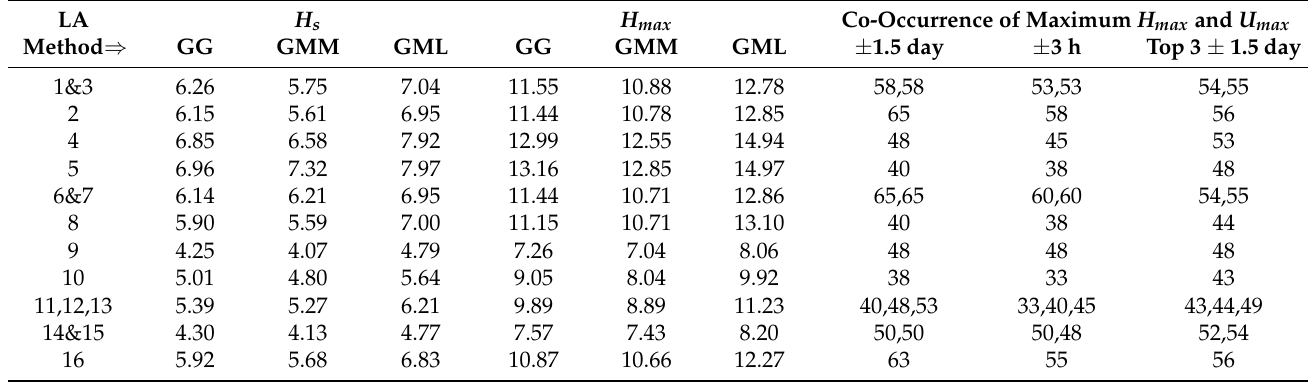
Figure 9. Time series of annual maximum wave heights H max from ERA5 for the LA shown in Figure 1. The top panel shows results for the northern group of LA (1–7) off the coast of MA/RI, the center panel shows the mid LA 8–13 off the coasts of NY, NJ, DE and MD and the lower panel the south LA 14–16 off the coast of VA and NC. The color coding for the individual LA is shown in Figure 1b. Because the ERA5 grid for wave data is at a lower resolution, some of the LA are in the same ERA5 grid (1&3, 6&7, 11,12 & 13, 14&15) hence these data points overlie each other. Table 4. One-year return periods for H max and H s (m) for the different LA determined by three different methods. LA that are within a common ERA5 grid cell for wave output are clustered in the same row. Also shown is the co-occurrence of annual maximum H max and U max sampled in three different ways; in the first analysis co-occurrence was specified as the percentage of the 40 years wherein the maximum absolute wave height occurred within 1.5 days of the maximum wind speed (headed; ± 1.5 day), or a ± 3 h time window of the maximum wind speed (headed; ± 3 h), and the percentage of the top 3 events in each year co-occurring within a time window of ± 1.5 days of the maximum wind speed (headed; Top 3 ± 1.5 day). Note because of the higher resolution of the wind output the results for two LA may derive a common wave grid cell but different wind grid cells. Hence multiple results are reported for those LA.